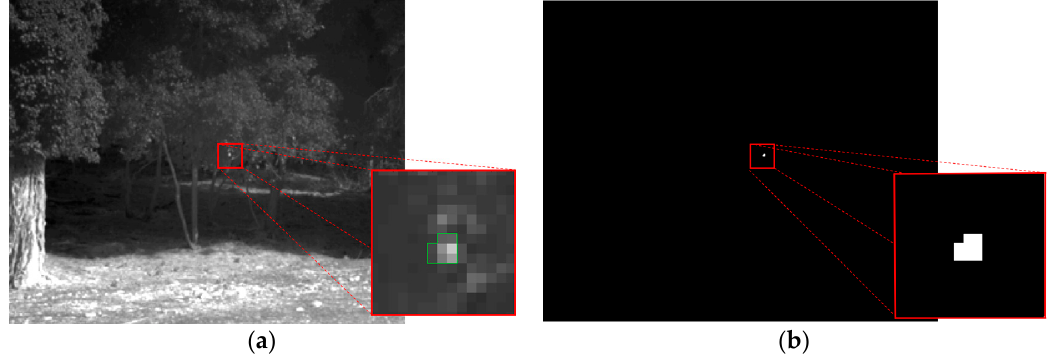
Figure 3. Example frame of a video sequence containing a small and fast moving object, contoured in green in the zoomed box ( a ); and corresponding detection map output by the proposed algorithm ( b ).